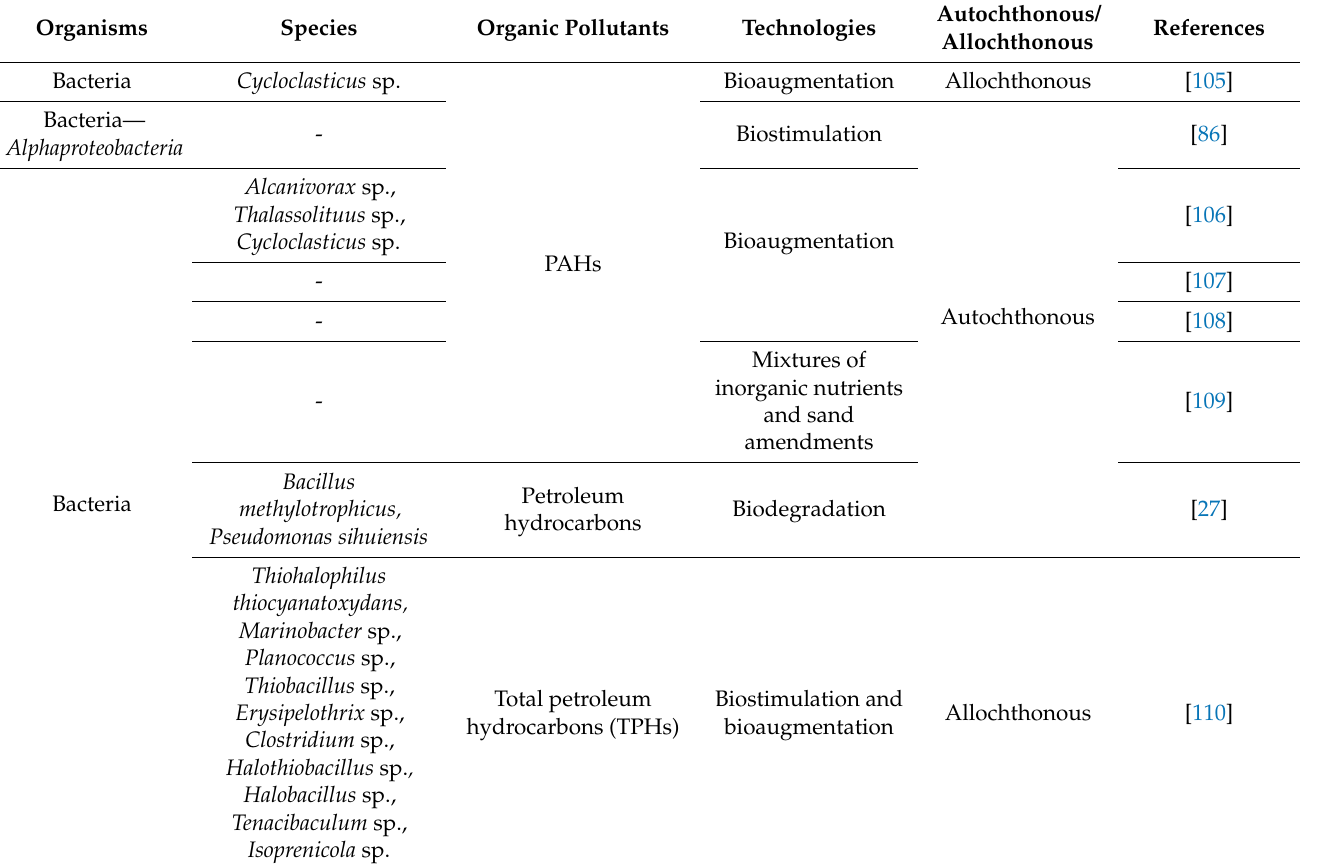
Table 2. List of the main microorganisms and bioremediation techniques of marine sediments contaminated by organic